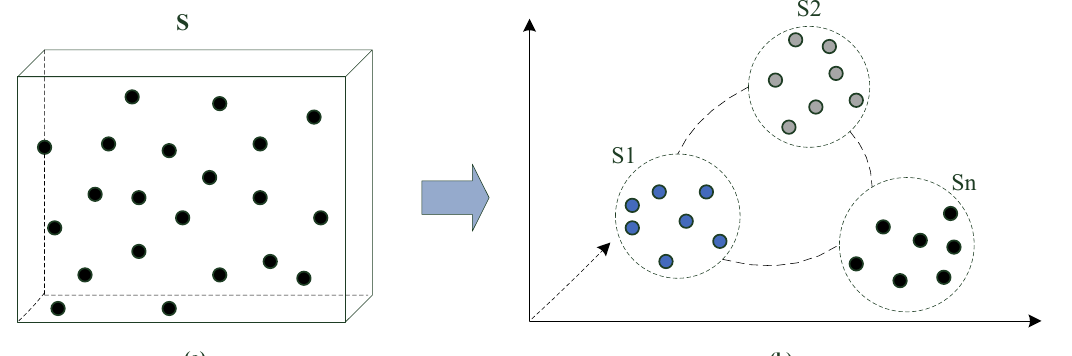
Fig.2. Clustering States. (a) original state; (b) final optimal